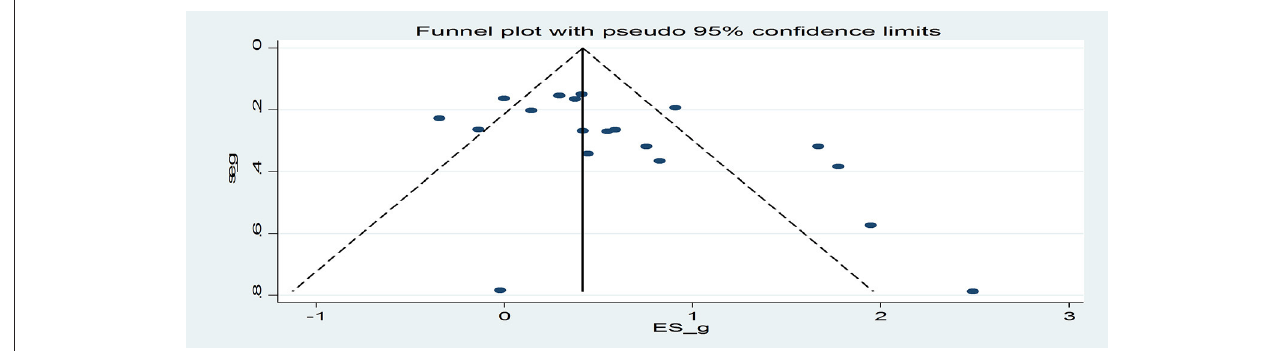
FIGURE 3 | Funnel